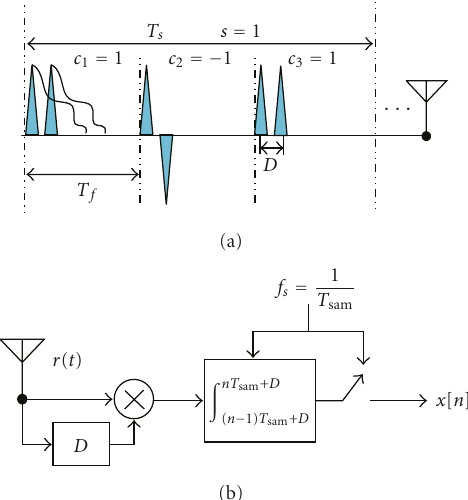
Figure 1: The transmitted UWB signal and the receiver structure.